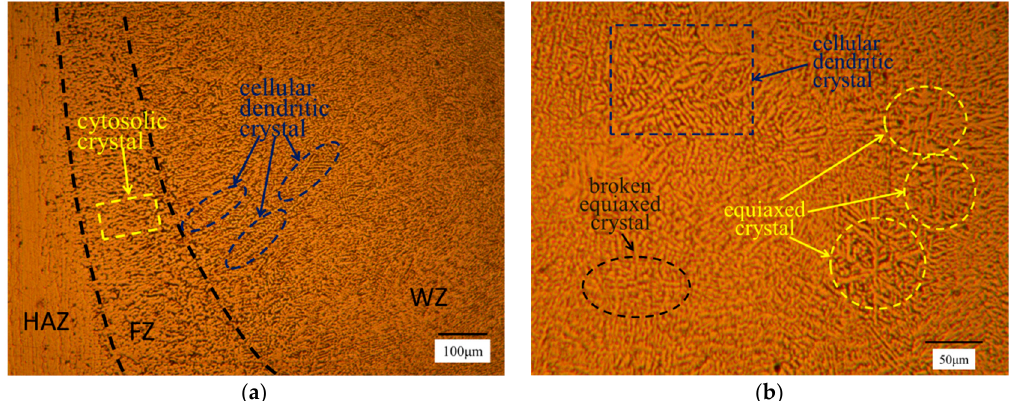
Figure 3. Microstructure of weld joint of MIG-welded T joint of 6082 aluminum alloy. ( a ) Grain-boundary growth mode of weld pool; and, ( b ) grain structure of weld center.